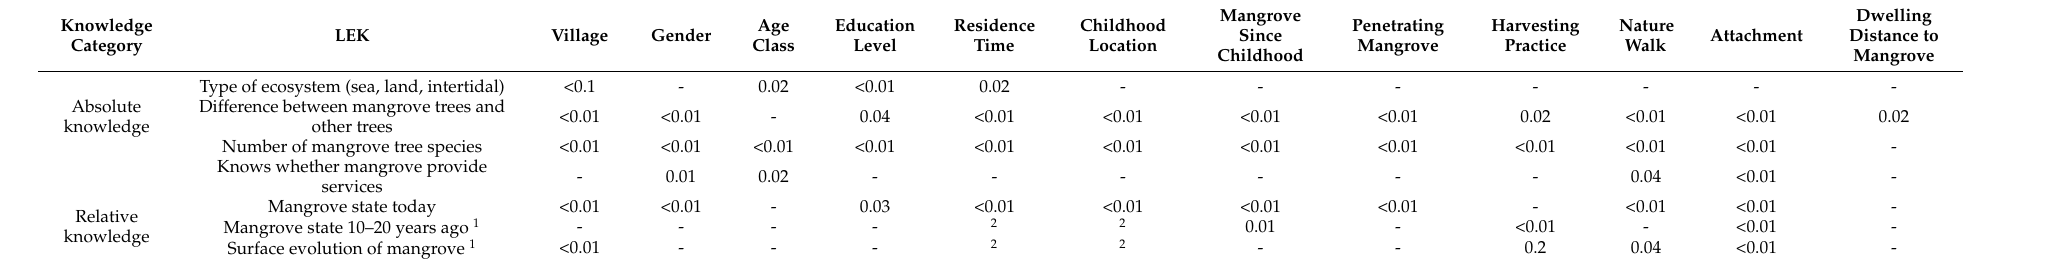
Table 3. Factors influencing significantly the local ecological knowledge (LEK) of